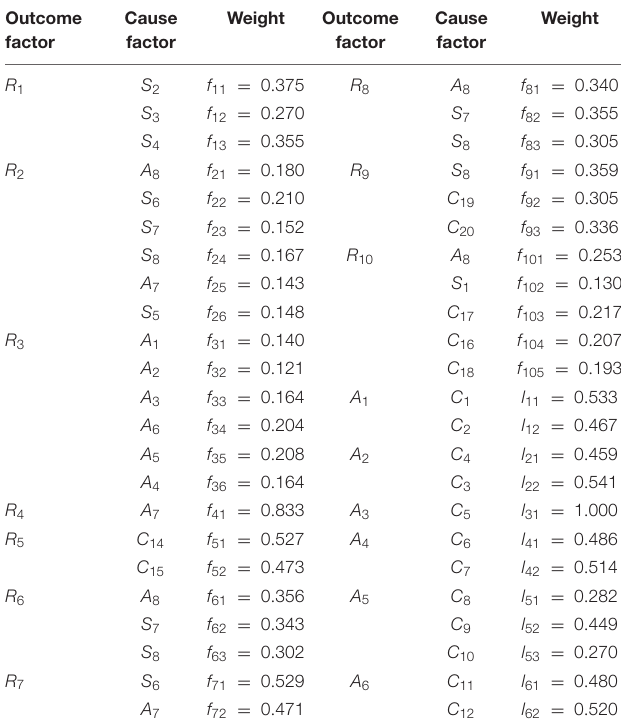
TABLE 7 | The weight of factors.